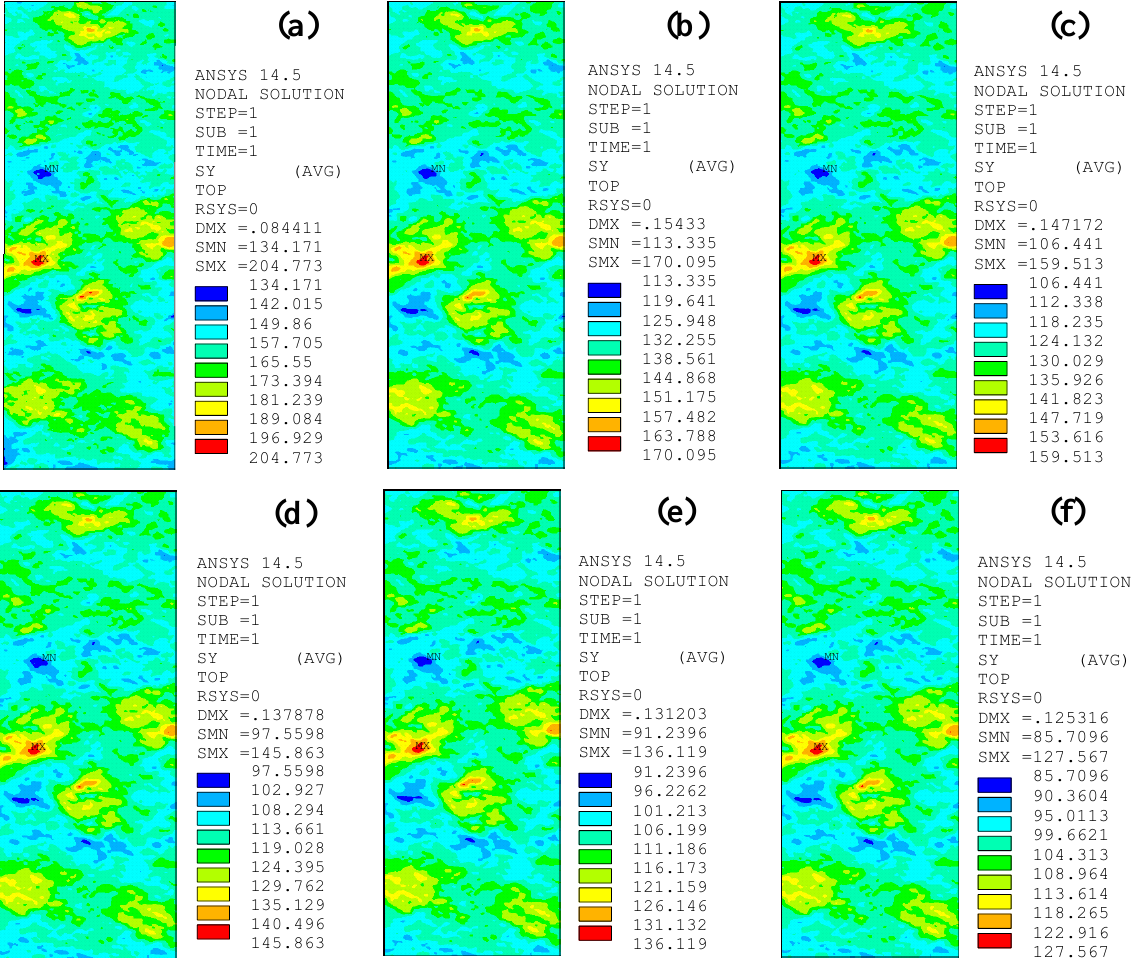
Figure 15. Peak tensile stress distribution on the corroded steel surfaces of the patched specimens with various CFRP strengthening stiffnesses: ( a ) C9-1, ( b ) C9-DS1.0-A1.0, ( c ) C9-DS1.4-A1.0, ( d ) C9-DS2.0-A1.0, ( e ) C9-DS2.5-A1.0, ( f ) C9-DS3.0-A1.0.